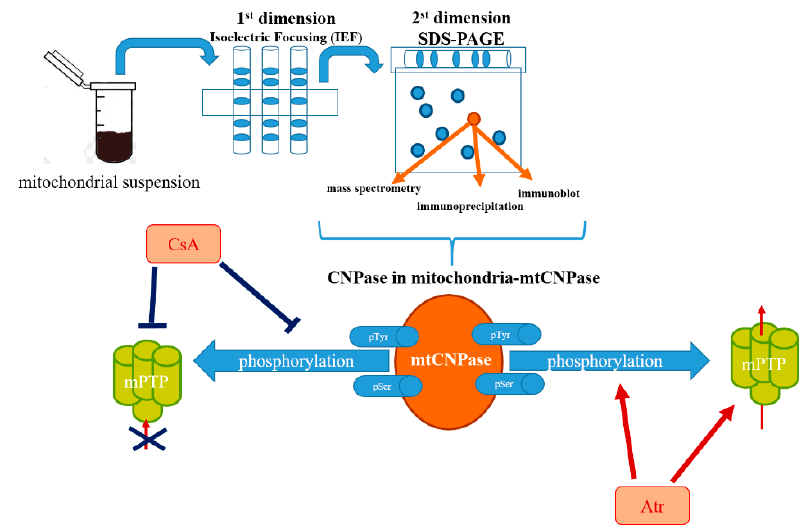
Figure 1. Schematic representation of the detection of mtCNPase in the mitochondria.